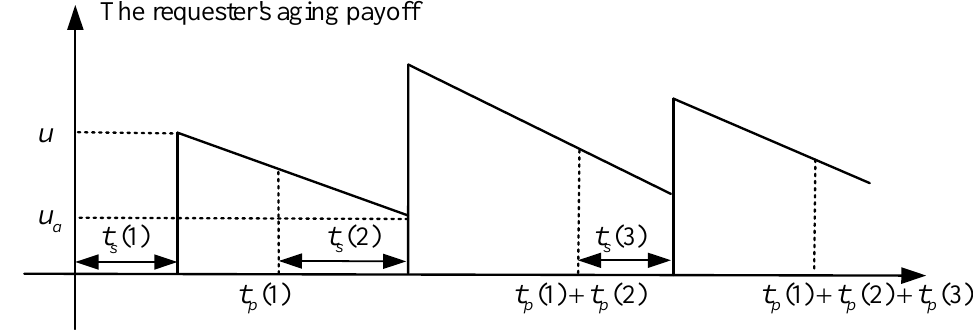
Figure 3. The information requester’s aging value of